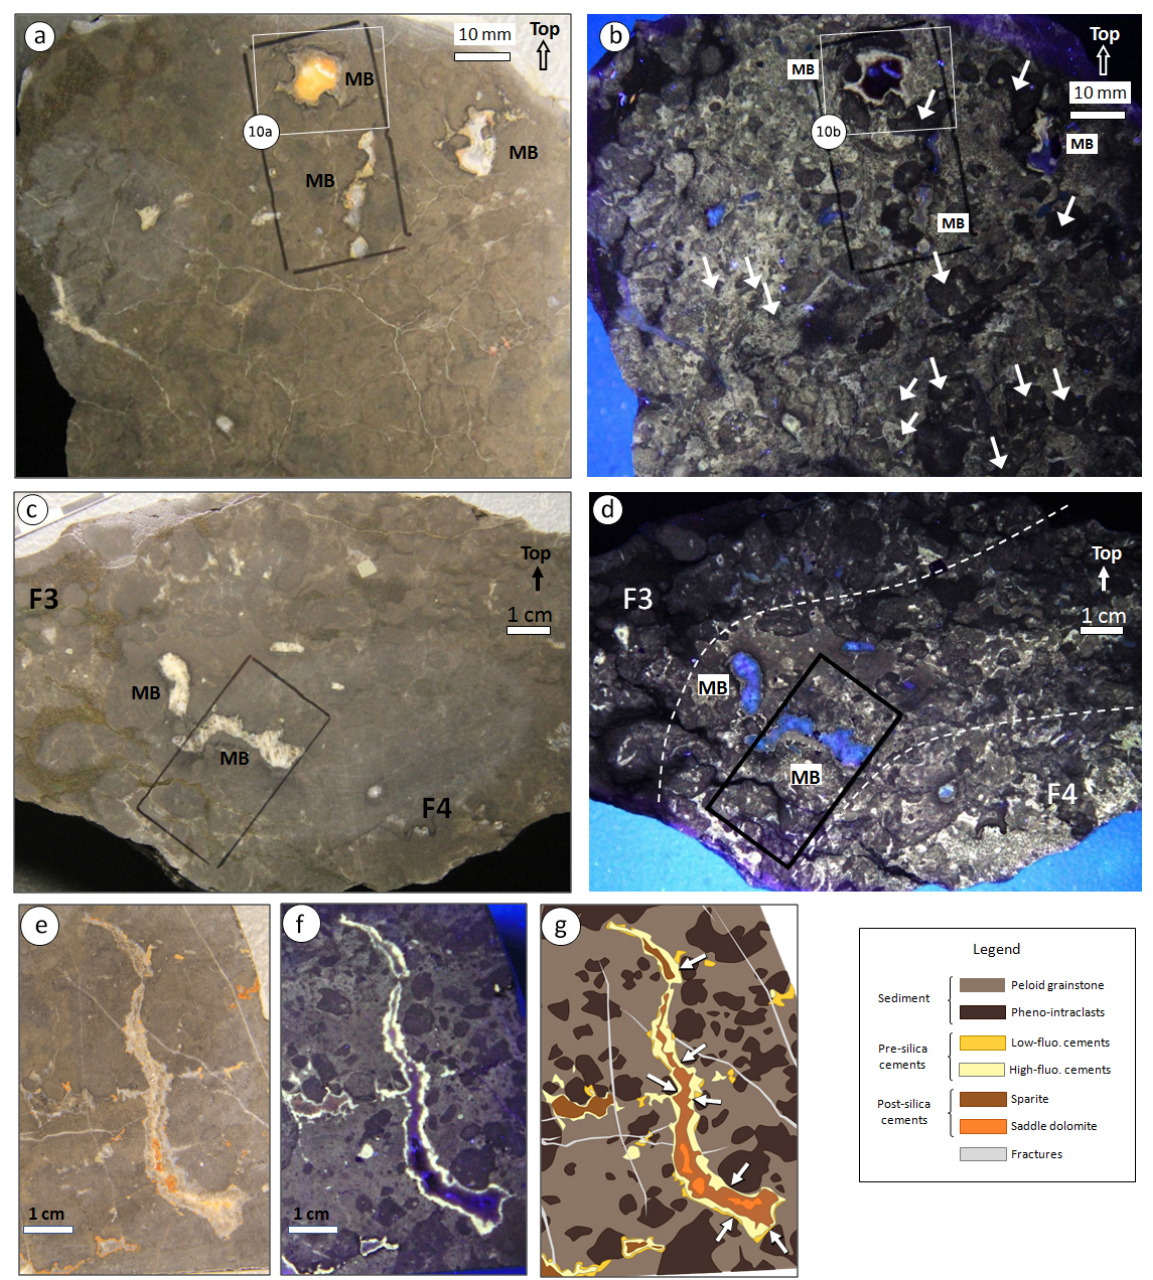
Figure 8. Fabric of intensely bioturbated sediment. (a) Natural light and (b) UV fluorescent light, Facies F4. White arrows in (b) point at some of the micrite pheno-intraclasts. Note the variability of pheno-intraclasts in roundness and size. MB: medium burrow. (c) Natural light and (d) UV fluorescent light, transition from F3 to F4. In both samples, MBs appear independent of variations in the fabric around them; black rectangles were drawn for thin section selection. (e) Natural light, (f) UV fluorescent light and (g) line drawing, Facies F4, unoriented vertical section. White arrows in (g) show points where the burrow’s edge is tangent to